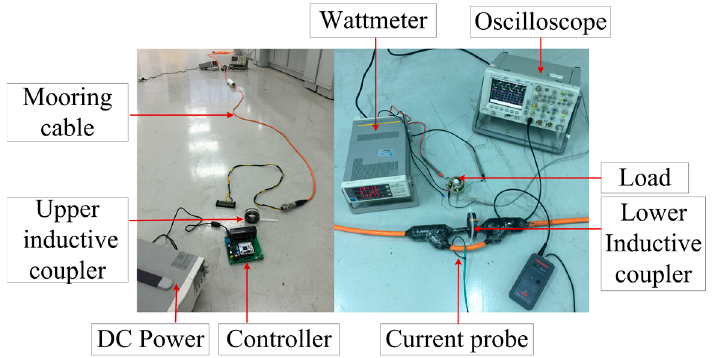
Figure 15. Experimental setup.